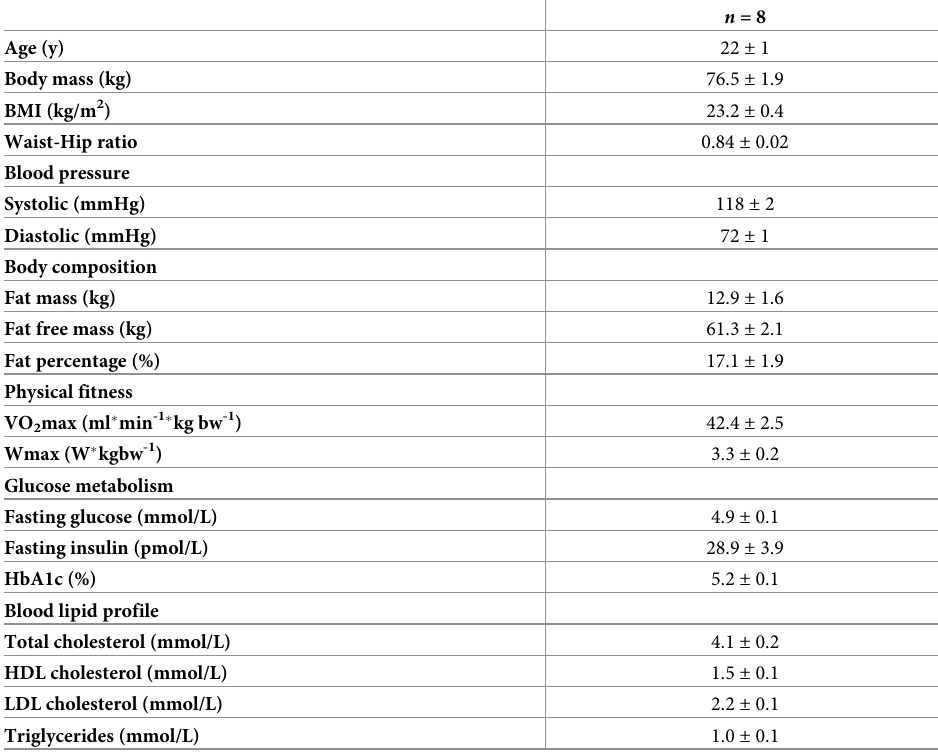
Table 1. Baseline participant characteristics.